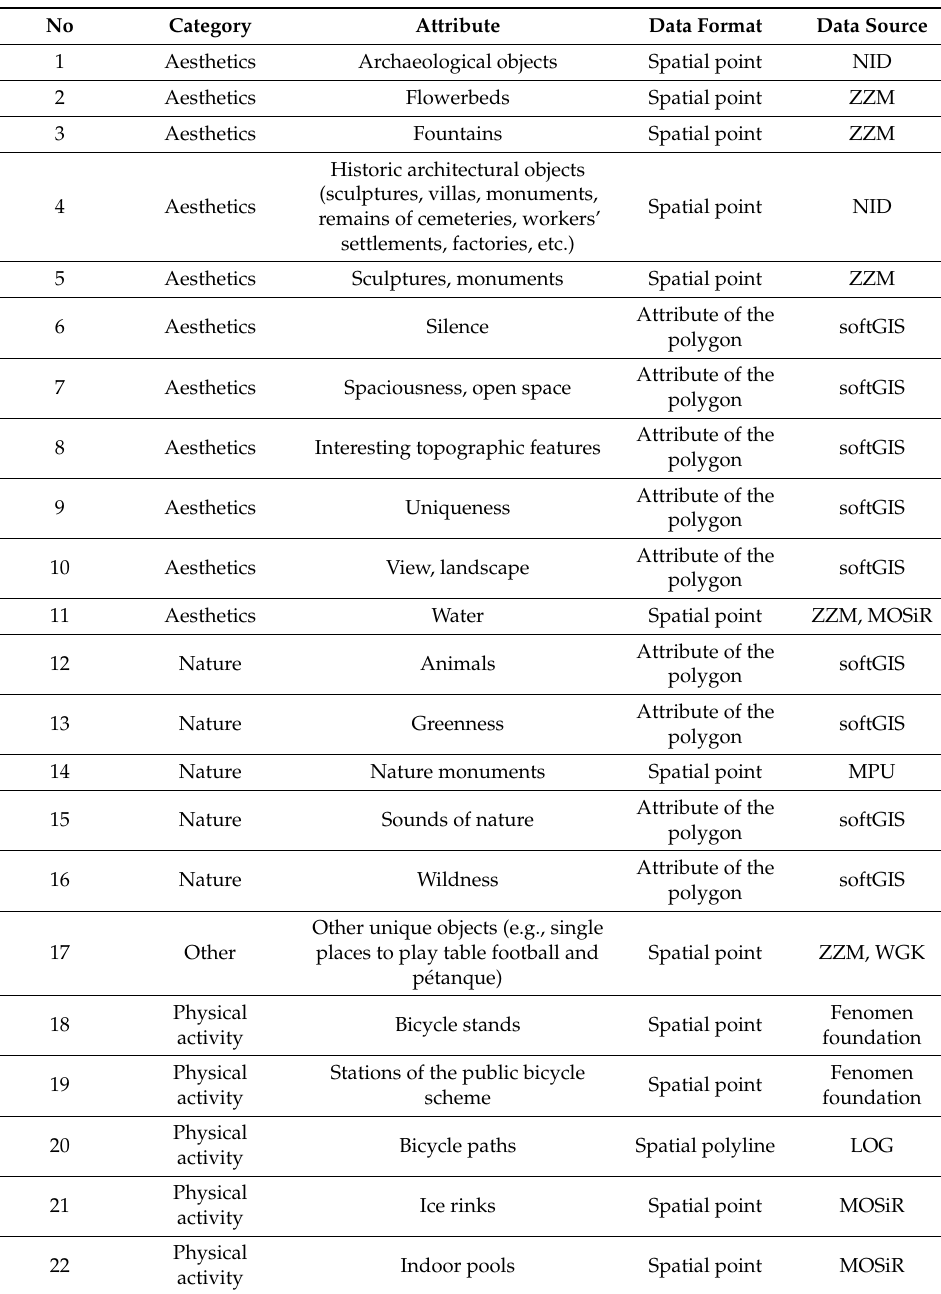
Table 1. The sociotope attributes in